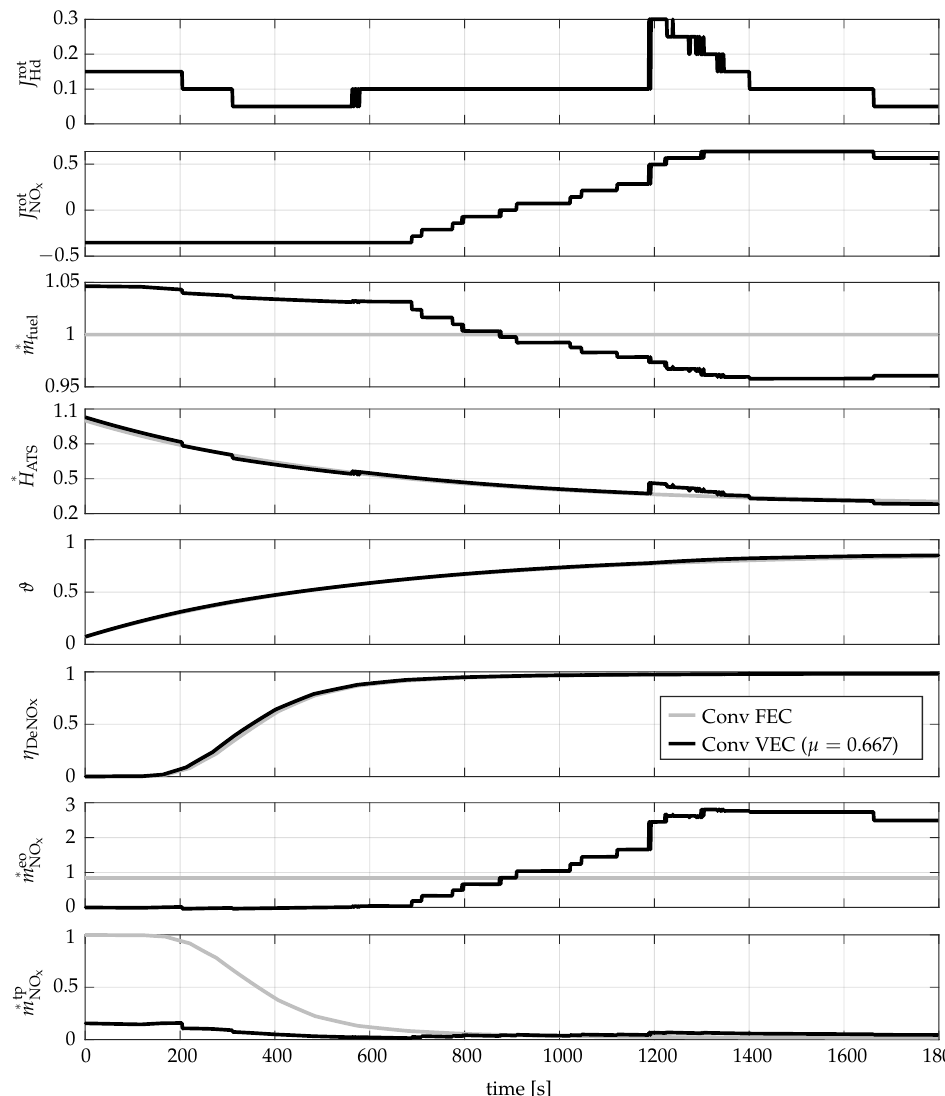
Figure 10. Comparison of operation with FEC to that with VEC for the simplified driving mission. All values were